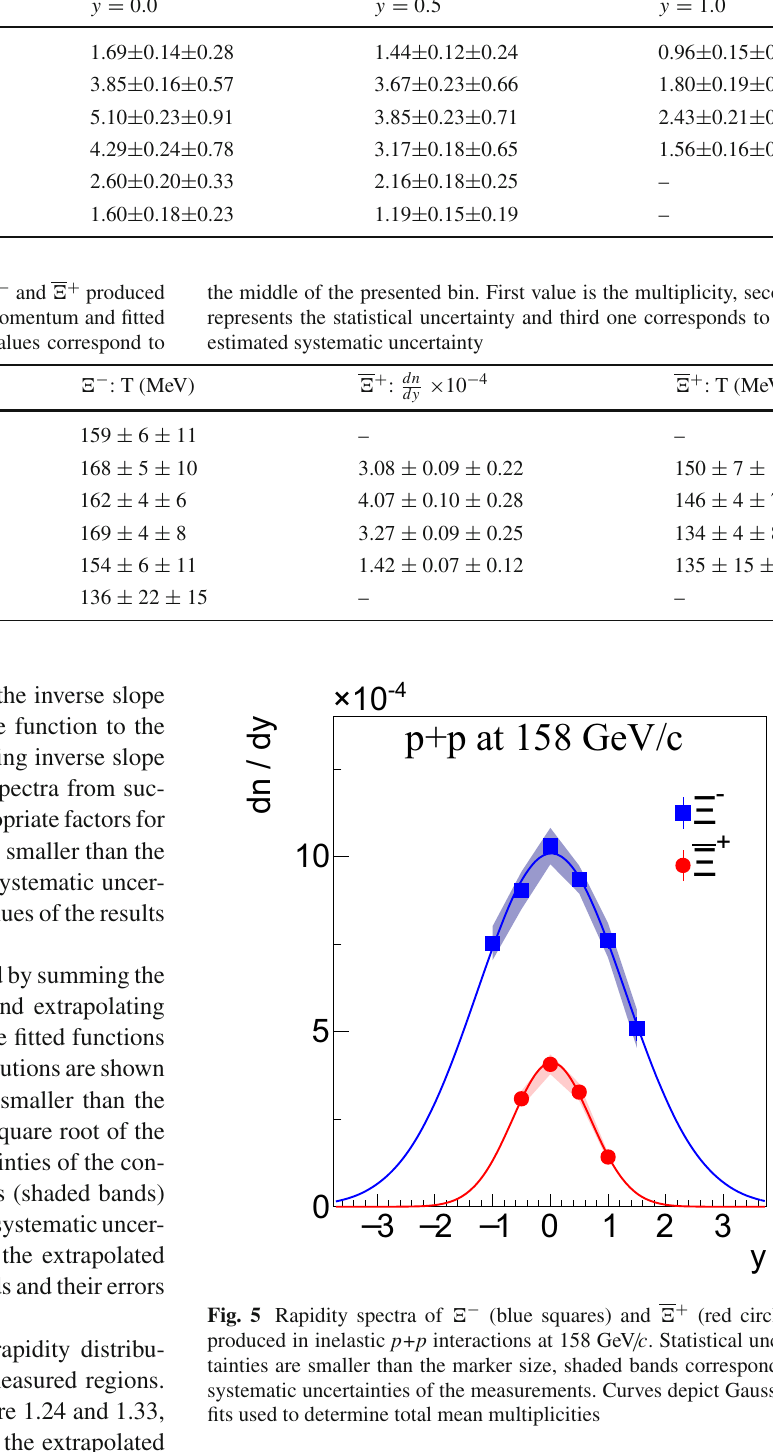
Table 3 Numerical values of double-differential spectra of (cid:2) + pro- duced in inelastic p+p interactions at 158 GeV / c beam momentum. Rapidity and transverse momentum values correspond to the middle of